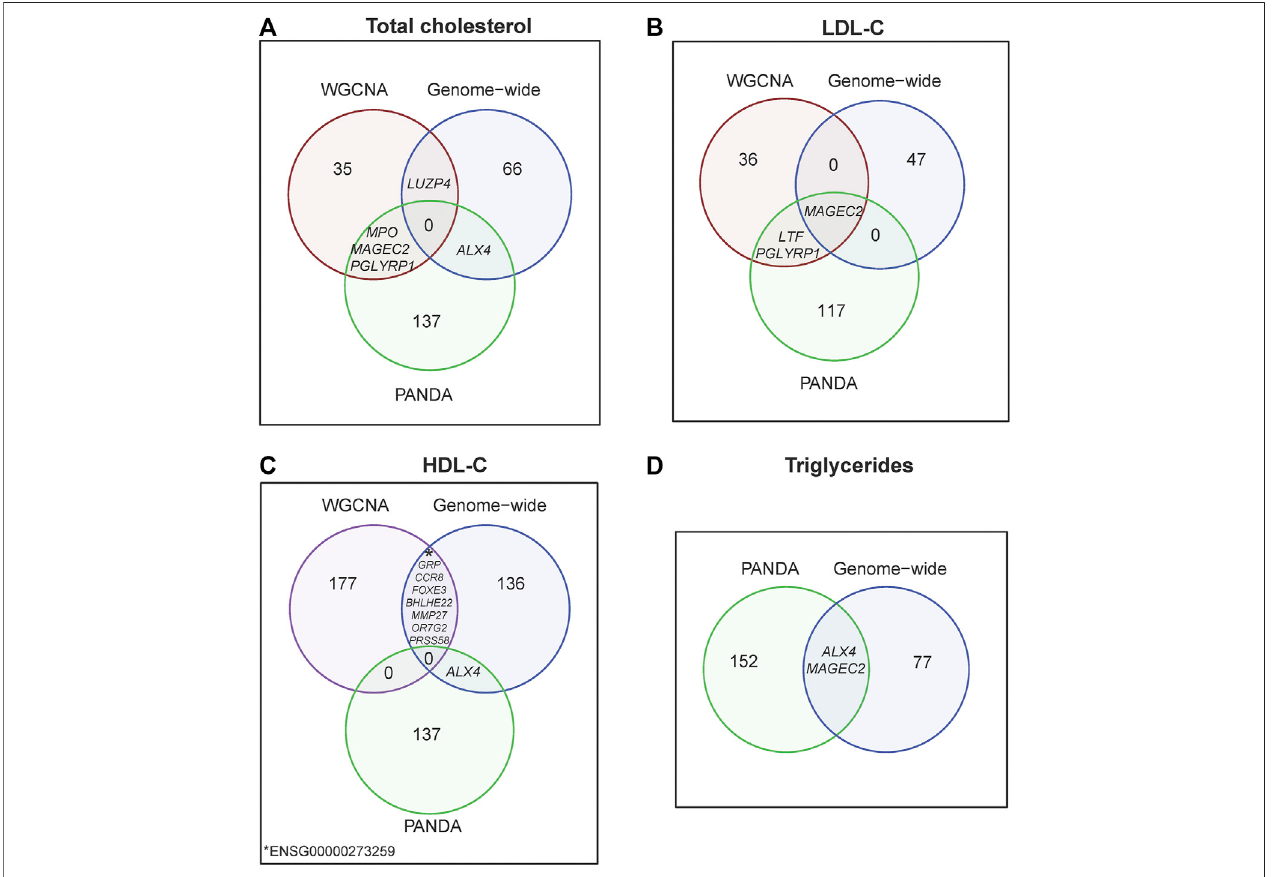
FIGURE 3 | Venn diagram by lipid traits (A) Total cholesterol, (B) LDL-C, (C) HDL-C and (D) Triglycerides, illustrating top-differentially expressed genes from WGNCA, PANDA and genome-wide analyses.